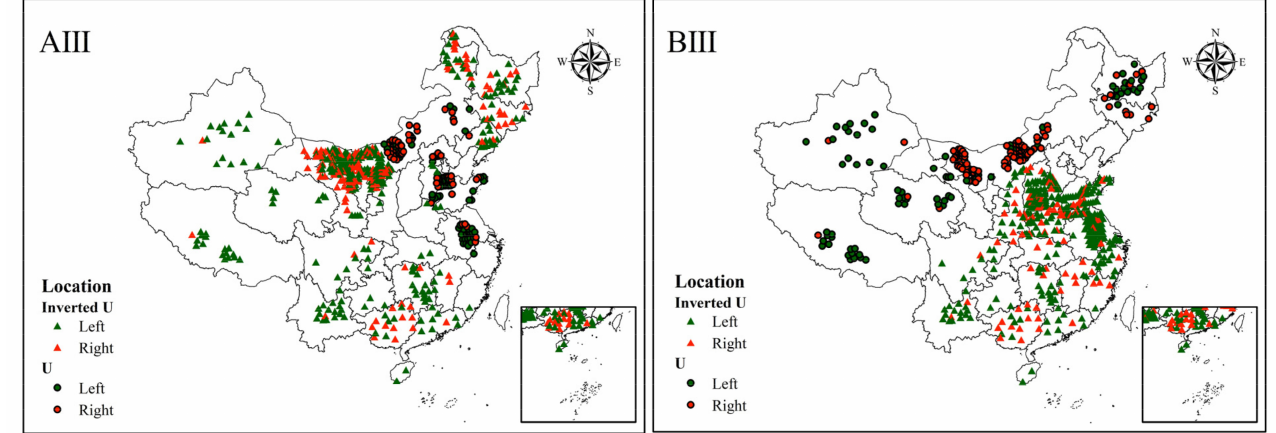
Figure 4. The EKCs’ shapes ( upper ), inflection points ( middle ), and where the current income positions are relative to the inflection points ( lower ). Notes: In the upper two panels, 1 represents a negative relationship between income and WTPEP; 2 indicates an inverted U-shaped relationship between income and WTPEP; 3 means a U-shaped relationship between income and WTPEP; 4 stands for a positive relationship between income and WTPEP. ( AI – AIII ) stands for before COVID-19, ( BI – BIII ) represents during COVID-19, the same